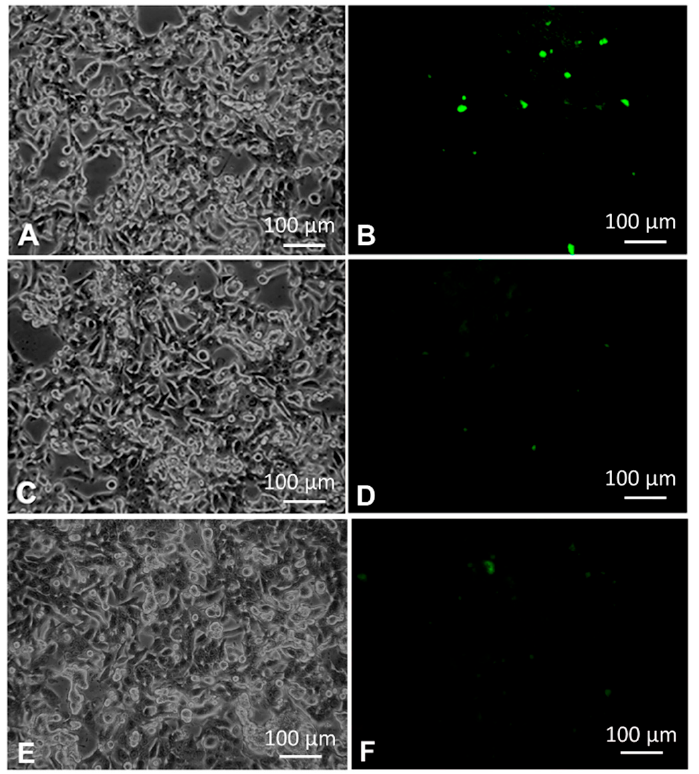
Figure 4. Optical (left panel) and fluorescence (right panel) images of SW480 cells: ( A , B ) cells transfected with GO@SurMB-Joe; ( C , D ) cells transfected with GO alone; ( E , F ) cells transfected with SurMB-Joe; transfection time: 4 h.